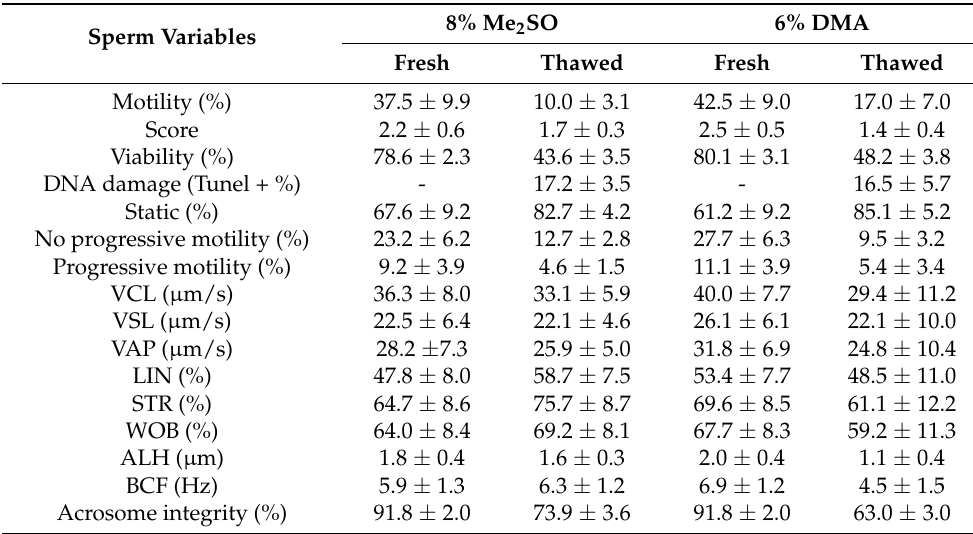
Table 1. American flamingo sperm variables in fresh and froze-thawed samples using two cryopro- tectant agents (8% Me 2 SO and 6% DMA).